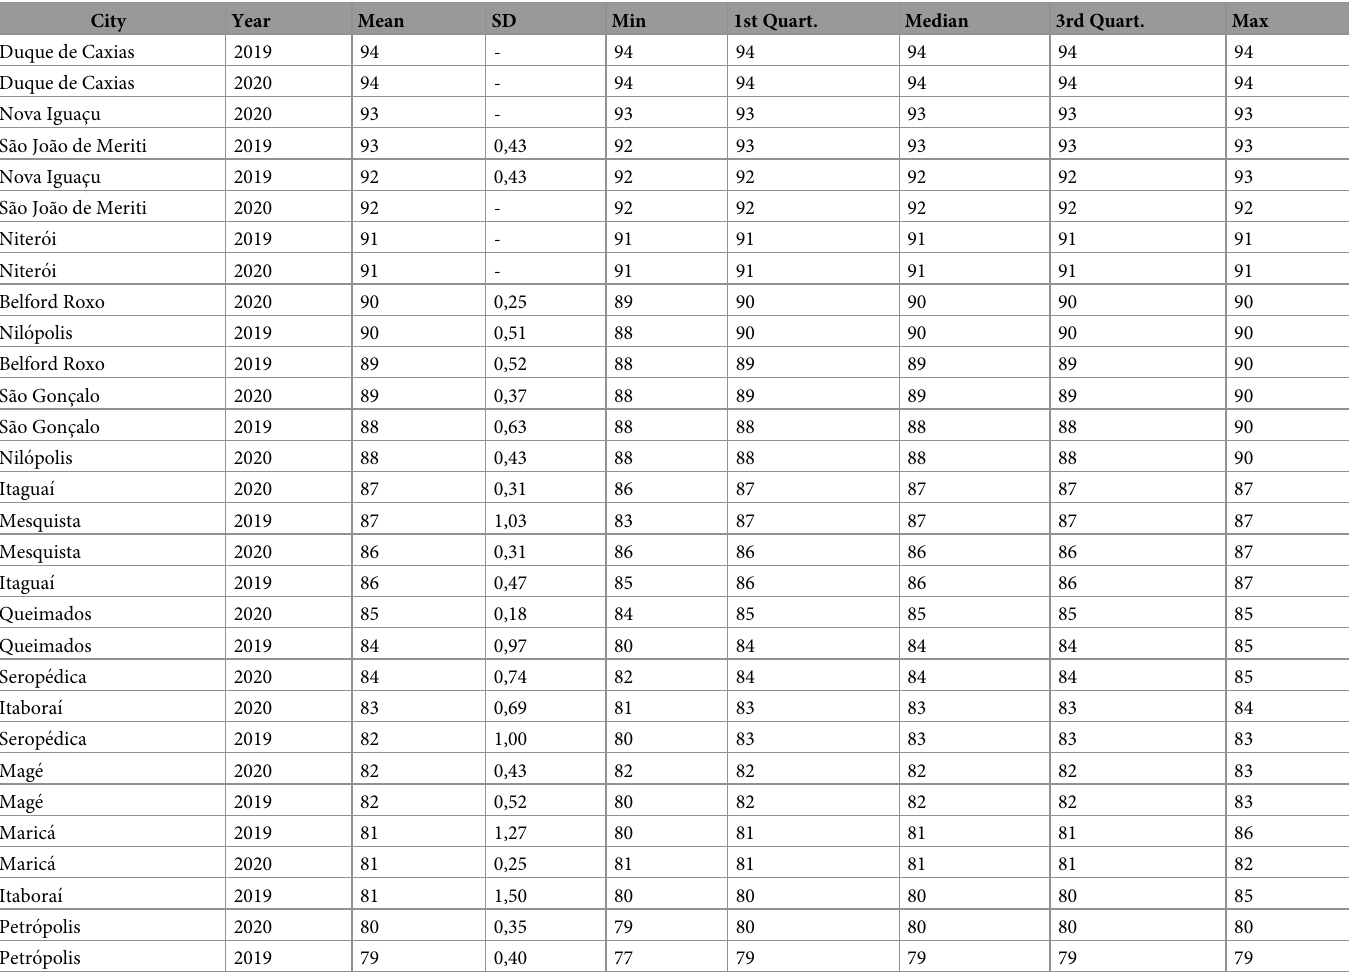
Table 3. Descriptive statistics of the rank of the proportion of movement out of Rio de Janeiro capital city in the days of March 2019 and March